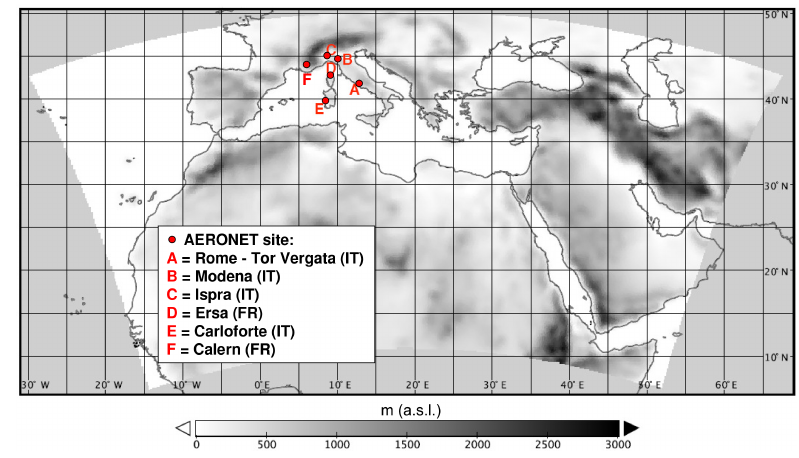
Figure 1. The numerical domain/topography and location of the AERONET stations used in this study. Table 1. Namelist settings of the physical parameterizations used in the WRF-Chem setup. Option Namelist variable Model number Land surface 3 sf_surface_physics RUC model PBL model Surface